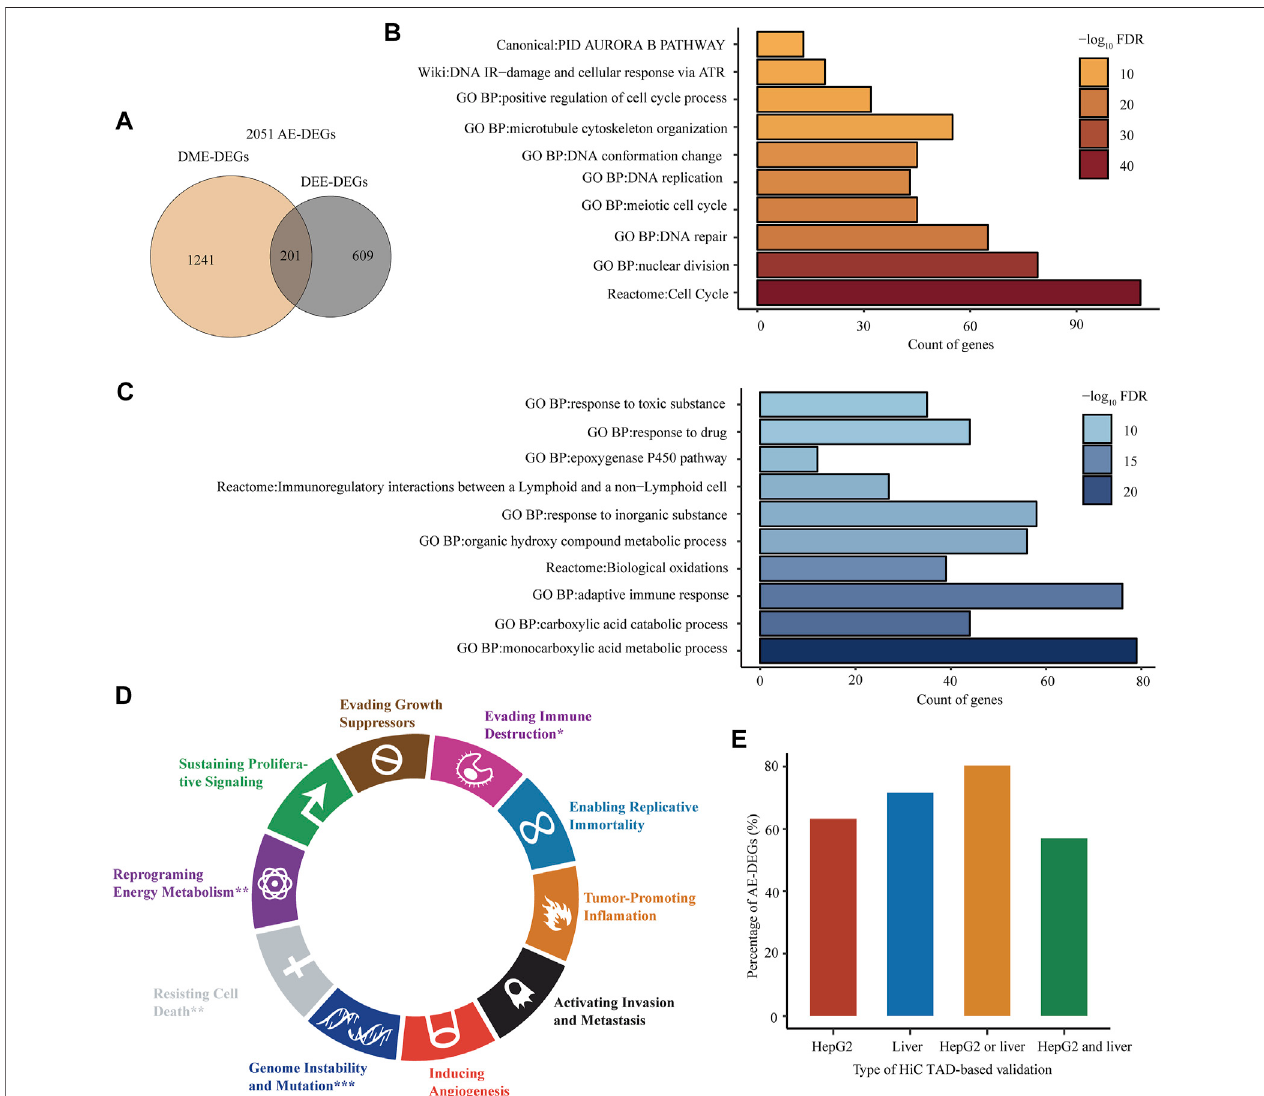
FIGURE 6 | Biological functions and in silico veri fi cation of AE-DEGs. (A) Venn diagram displaying the overlap between genic DME-DEGs and intergenic DEE- DEGs. The union of them were de fi ned as aberrant enhancer-associated DEGs (AE-DEGs). (B) and (C) Top ten overrepresented pathways/GO terms of activated AE- DEGsandrepressedAE-DEGs,respectively. (D) EnrichmentofAE-DEGsfortencancerhallmarks. “ * ” referstohypergeometrictestFDR < 0.05; “ ** ” referstoFDR < 1e-2; and “ *** ” refers to FDR < 1e-3. (E) Percentage of AE-DEGs that were successfully validated by TADs in HiC-pro fi led HepG2 and normal liver samples. “ HepG2 or liver ” refers to successful validation in HepG2 or the liver sample; “ HepG2 and liver ” refers to successful validation in both HepG2 and the liver sample.